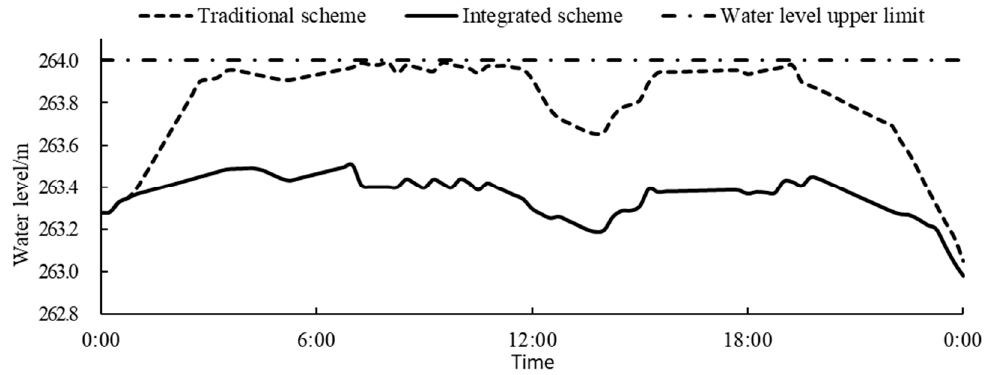
Figure 4. Water level variation of each scheme in the 1st operating condition.